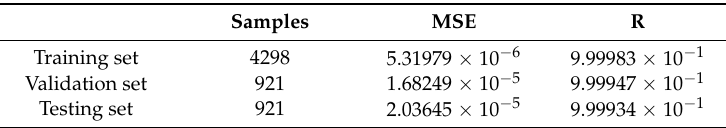
Table 1. Training results for one of 8099 neural networks.